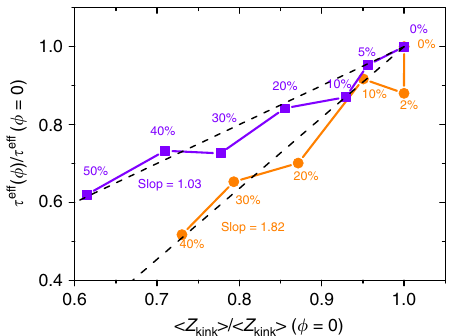
Fig. 6 Chain relaxation time τ eff at p ¼ 1 plotted as a function of average number of entanglements per chain h Z kink i in composite systems. ‘ PS500/ NP250 ’ (squares) and ‘ PS720/NP250 ’ (circles) with different NP loadings ( ϕ ). They are both normalized by the corresponding values in pure PS melts with ϕ ¼ 0. fi nd a disentanglement effect in the system, i.e., h Z